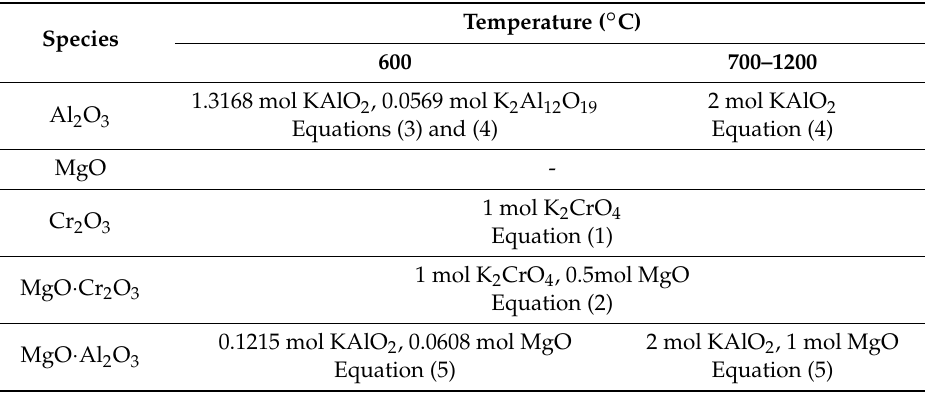
Table 1. Corrosion products and reaction equations of K 2 CO 3 reacting with the five components of refractory